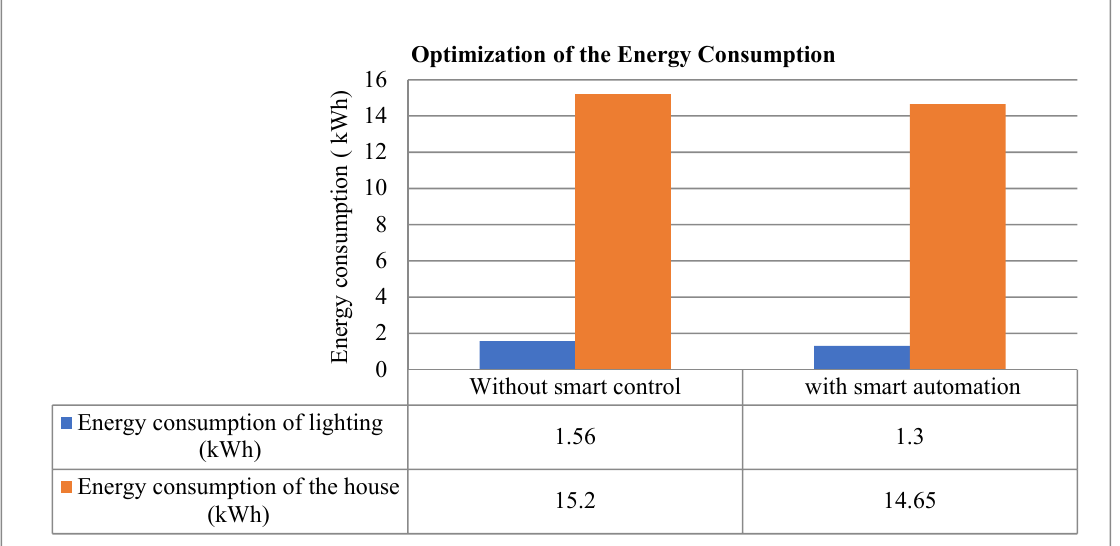
Figure 18. Graph summarizing the values of energy consumption of the lighting and the house.